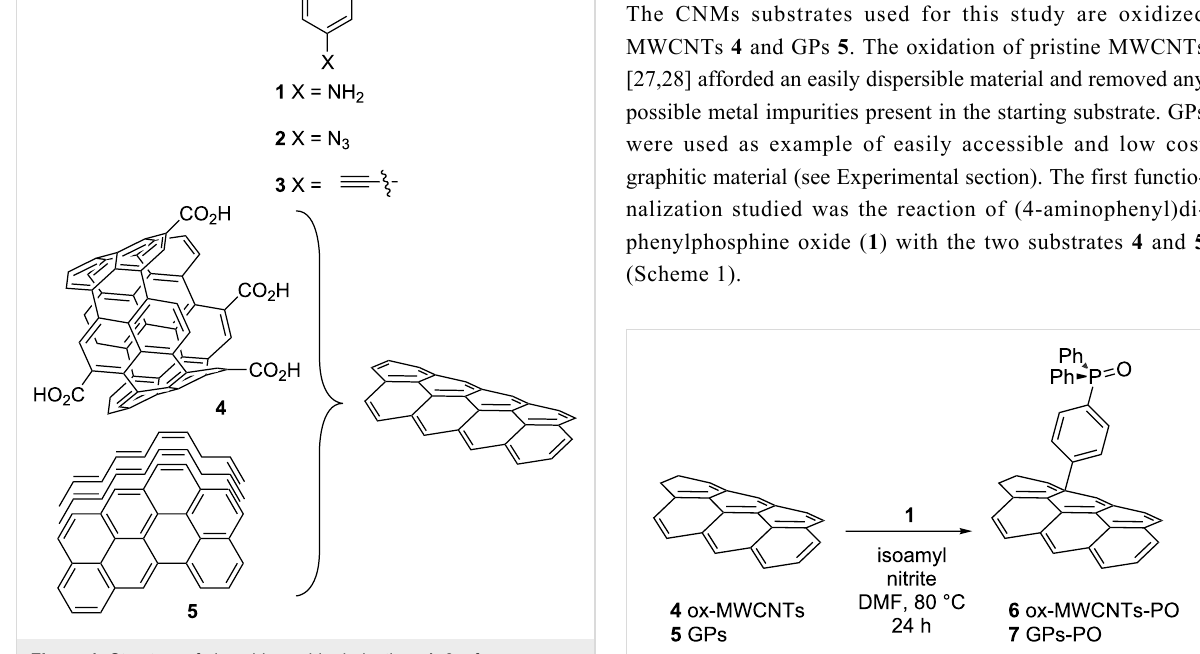
Figure 1: Structure of phosphine oxide derivatives 1 – 3 , of ox-MWCNTs 4 and of GPs 5 .